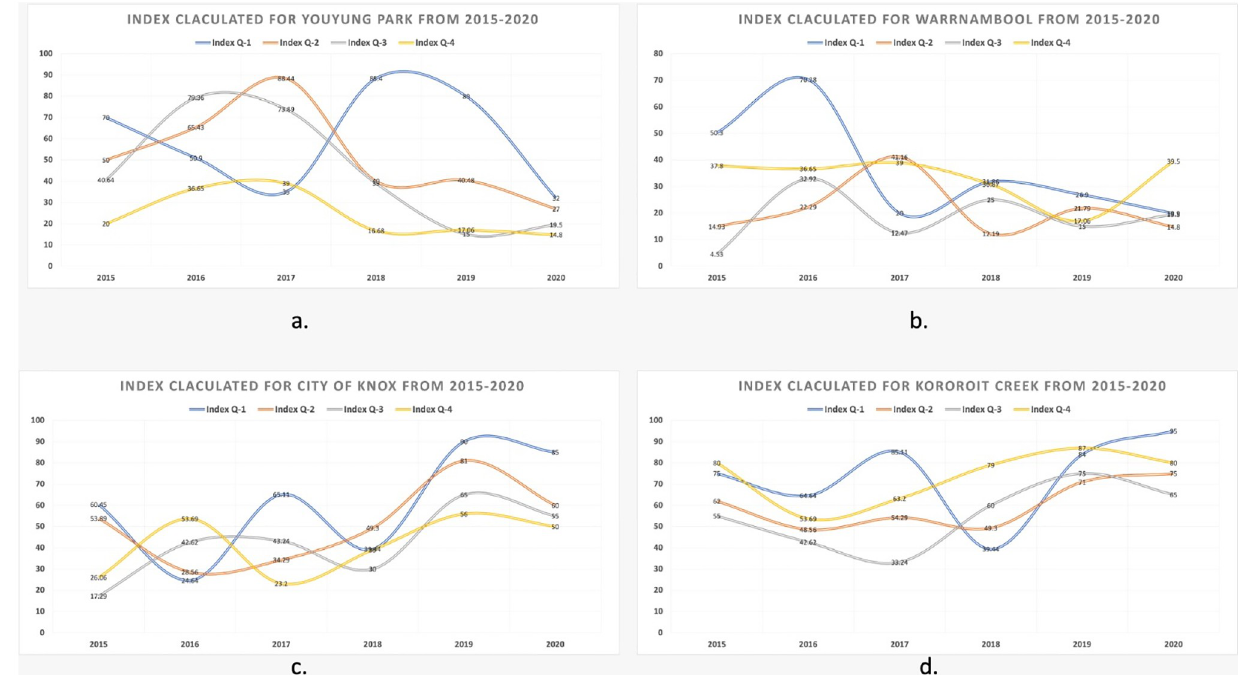
Fig 11. Figures depicting the average semantic vegetation index calculated quarterly from 2015 to 2020 for a.) Youyung Park, b.) Warrnambool region, c.) City of Knox, and d.) Kororoit Creek site.